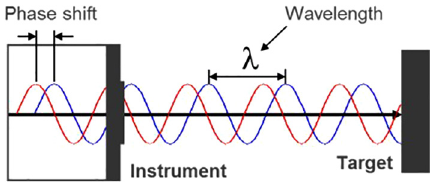
Figure 2. Phase shift technology